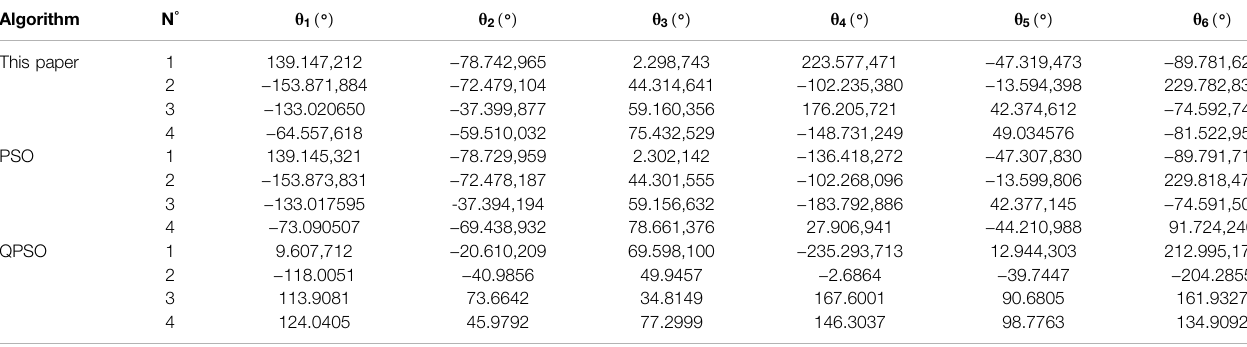
TABLE 7 | The six joint angles corresponding to the impact points obtained by different algorithms.